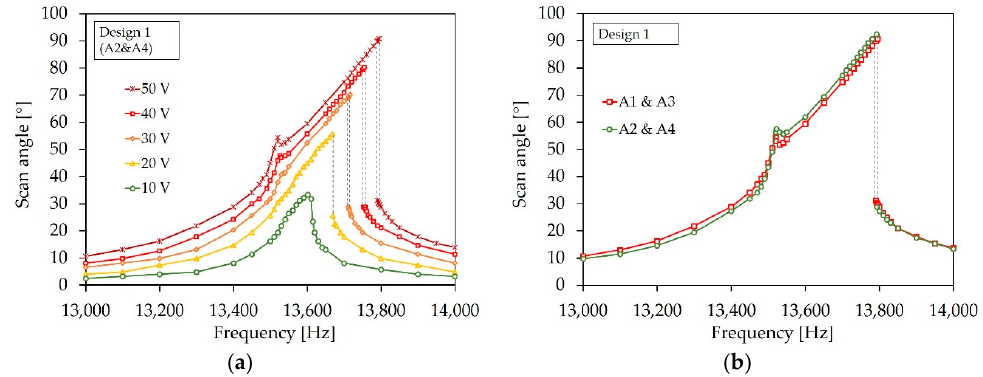
Figure 24. Frequency response curves of Design 1: ( a ) Actuation with actuator pair A2 and A4 for different voltages; ( b ) Comparison of the frequency response curves, generated at actuation of A1 and A3 and A2 and A4 at 50 V.